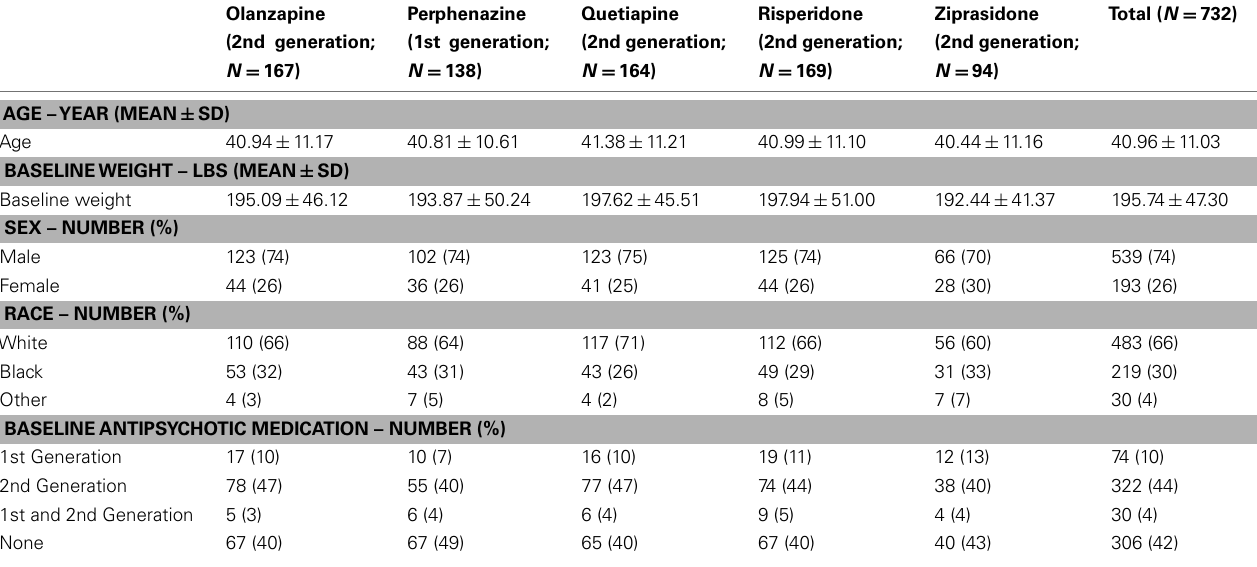
Table 1 | Baseline covariates and antipsychotic drug history of patients with available genotypic data prior to